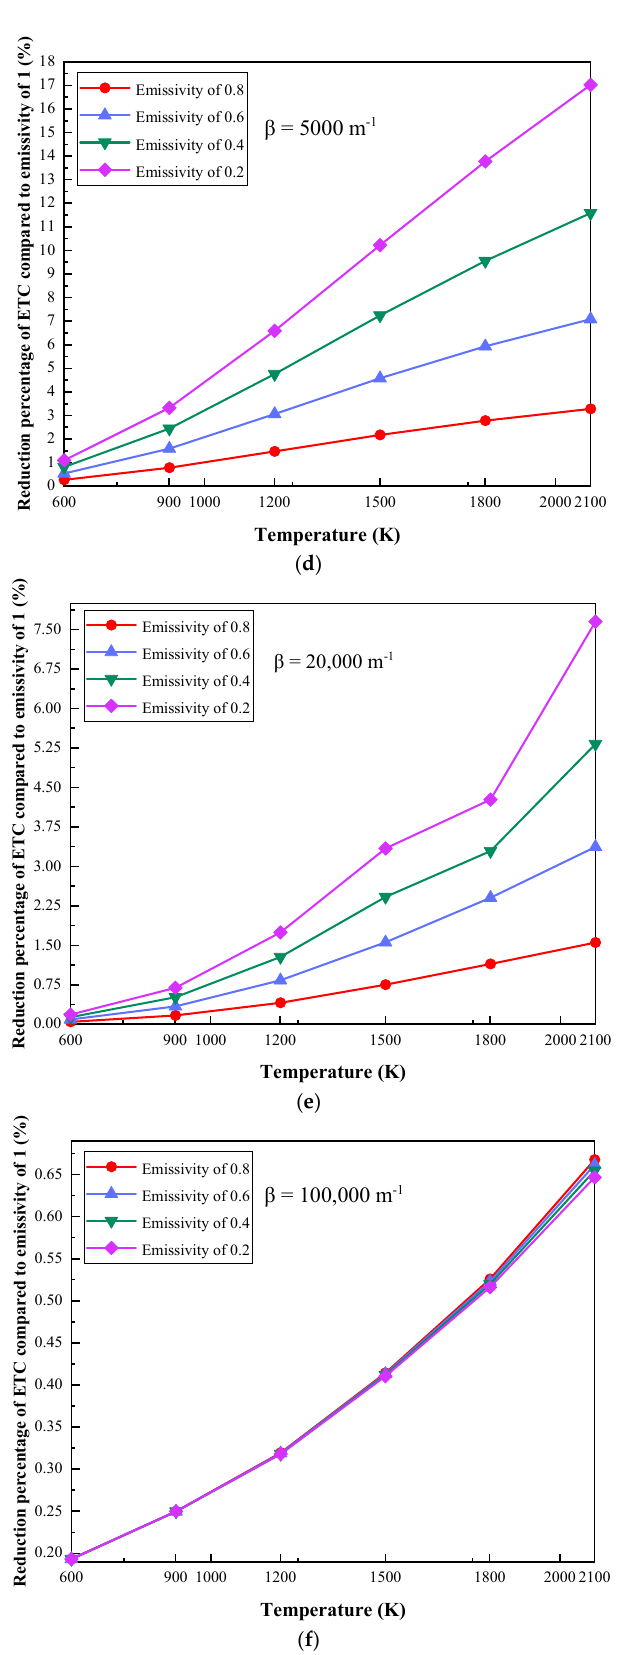
Figure 6. Reduction percentage of ETC compared to an emissivity of 1: ( a ) β = 50 m − 1 , ( b ) β = 500 m − 1 , ( c ) β = 1000 m − 1 , ( d ) β = 5000 m − 1 , ( e ) β = 20,000 m − 1 , ( f ) β = 100,000 m − 1